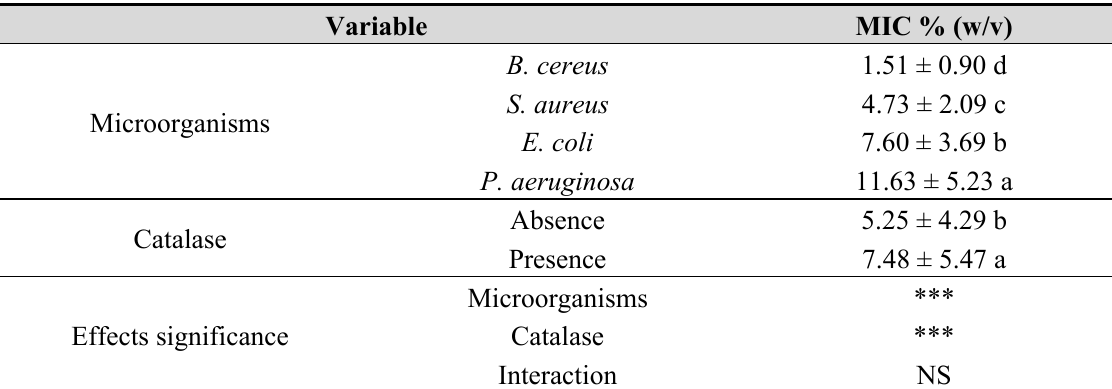
Table 1. Effect of the bacteria species, presence of catalase, and their interaction on the Minimum Inhibitory Concentration (MIC).